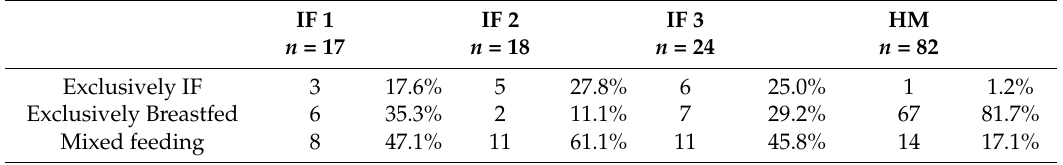
Table 2. Feeding of infants from birth to enrollment by group, as reported by mothers.